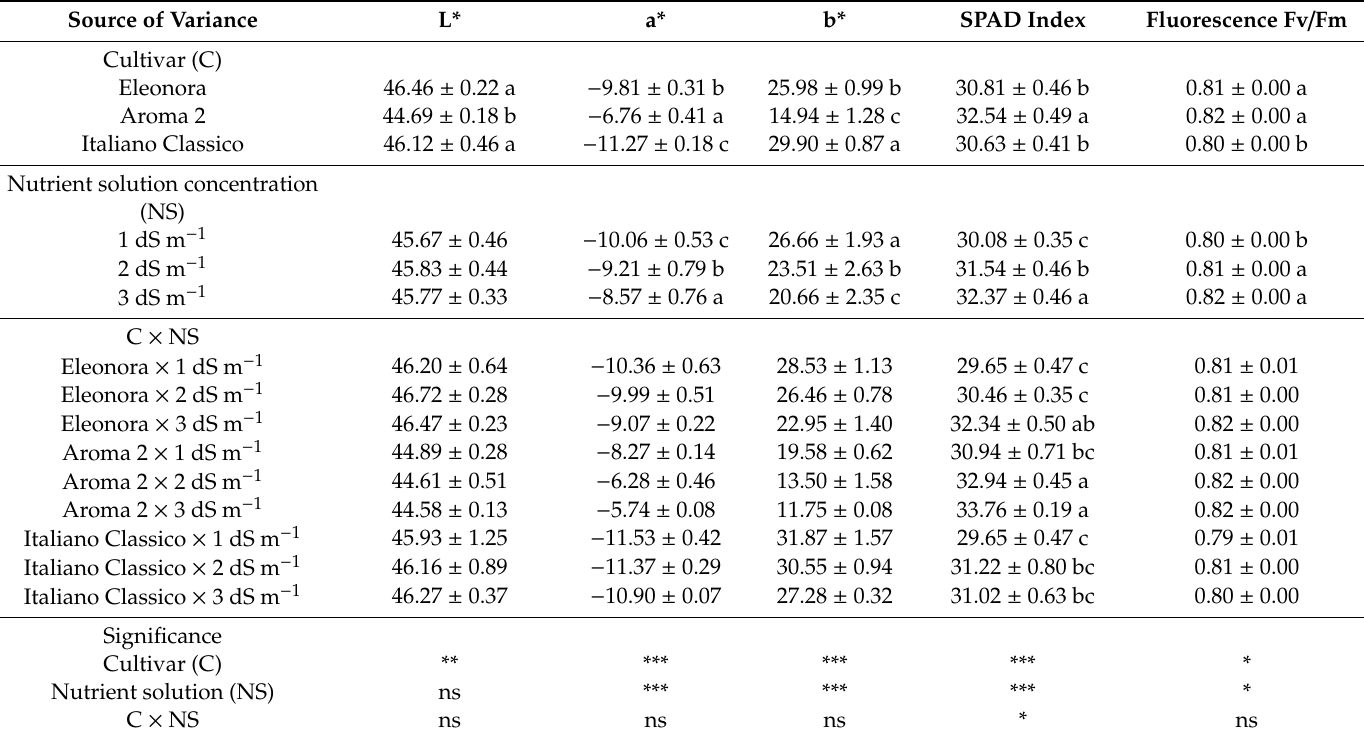
Table 2. Colorimetric indices, SPAD index and fluorescence in light of the cultivar and the nutrient solution electrical